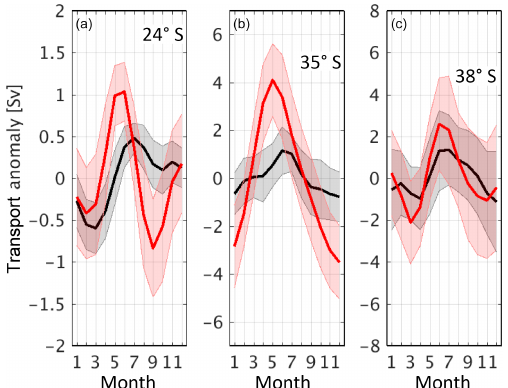
Figure 6. Annual cycle of the anomaly of the meridional transports in the Brazil Current derived from the time series in Fig. 5 for 24, 35, and 38 ◦ S from Argo&SSH (black) and HYCOM (red). Shad- ing indicates standard